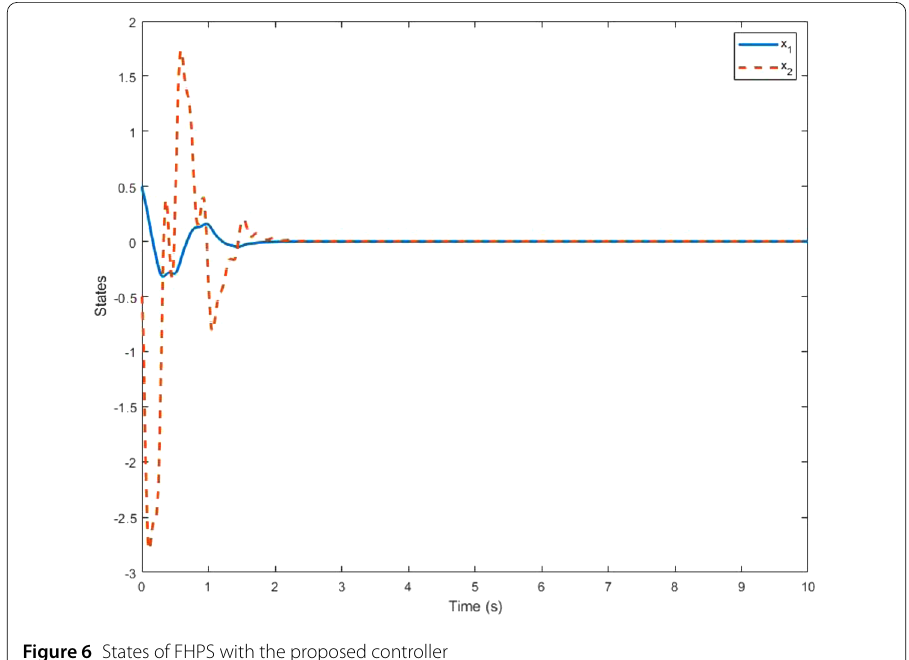
Figure 6 States of FHPS with the proposed controller